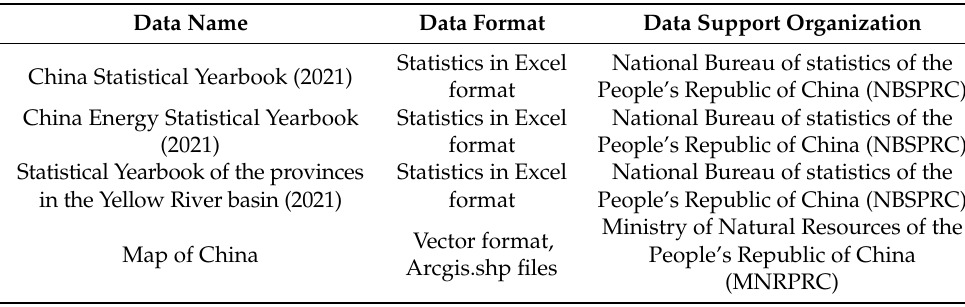
Table 2. Indicators and index interpretation of ecological product protection Table 1. Dataset source information.